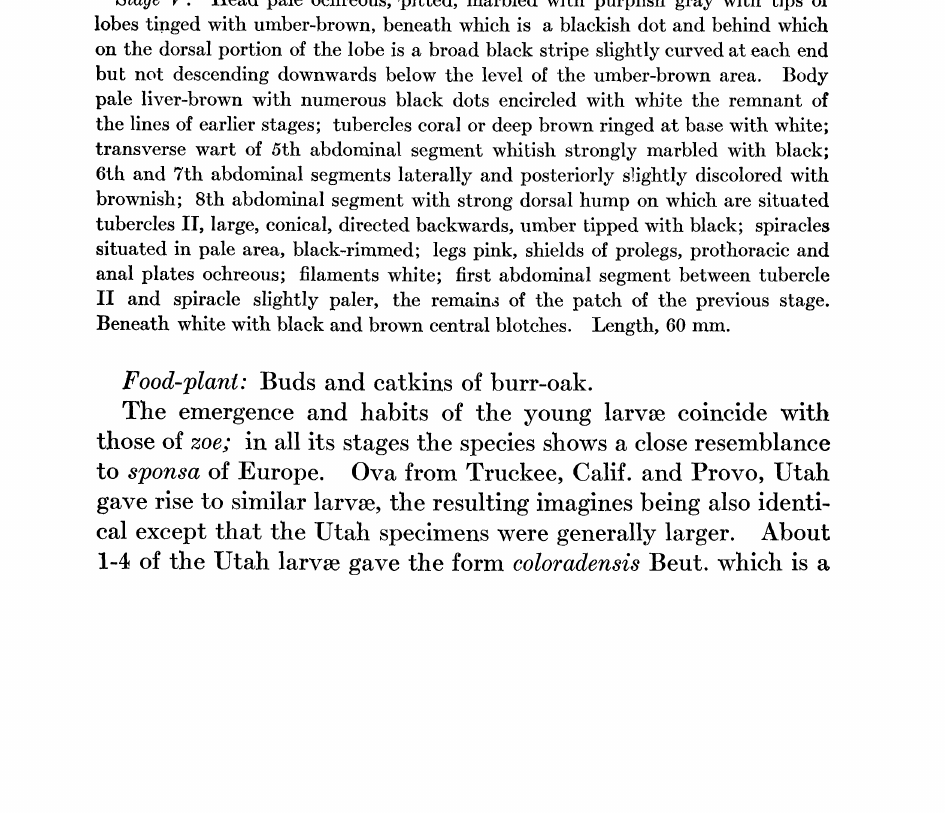
Psyche [December waved lateral lines and a third subspiracular one, much curved; tubercles large, black; slight dorsal transverse wart on the 5th abdominal segment and more prom- inent conical protuberance on dorsal portion of 8th" prolegs pale with black strips. Beneath whitish with prominent black patches. Length, 10 ram. Stage III. Head pale, strongly lined with black, apex of lobes tipped with orange behind which is a heavy black curved line; body gray-purple with distinct black tubercles which at times are orange-tipped; a prominent transverse blackish wart on 5th abdominal segment and a conical protuberanc tipped by tubercle II on 8th; similar lesser prominence on the 9th; lines and stripes as in preceding stage but broader and less distinct; lateral black shading below transverse wart of 5th abdominal segment. Length. 18 ram. Stage IV. Head pale creamy strongly lined with black in front and with apex of lobes tipped with orange behind which is heavy black marking. Body purple- brown, the 1st abdominal segment with pale creamy suffusion between and lateral to tubercles I and II, often very faint; stripes of previous stage not distinguishable but the black border lines have broken up into a series of irregular dotted lines on a more or less whitish ground, giving a general mottled appearance; tubercles orange, tipped with black and ringed at basewithwhite, the black color often predominating; transverse wart of 5th abdominal segment black, tipped with white at apex and defined laterally by the orange tubercles II; laterally to this is more or less oblique dark suffusion; prominent hump on 8th abdominal segment tipped by large conical tubercles II, orange in front black posteriorly. Beneath whitish with black central blotches. Length, 80 ram. Stage V. Head pale ochreous, .pitted, marbled with purplish gray with tips of lobes tinged with umber-brown, beneath which is a blackish dot and behind which on the dorsal portion of the lobe is a broad black stripe slightly curved at each end but not descending downwards below the level of the umber-brown area. Body pale liver-brown with numerous black dots encircled with white the remnant of the lines of earlier stages; tubercles coral or deep brown ringed at base with white; transverse wart of 5th abdominal segment whitish strongly marbled with black; 6th and 7th abdominal segments laterally and posteriorly s!ightly discolored with brownish; 8th abdominal segment with strong dorsal hump on which are situated tubercles II, large, conical, directed backwards, umber tipped with black; spiracles situated in pale area, black-rimmed; legs pink, shields of prolegs, prothoracic and anal plates ochreous; filaments white; first abdominal segment between tubercle II and spiracle slightly paler, the remainz of the patch of the previous stage. Beneath white with black and brown central blotches. Length, 60